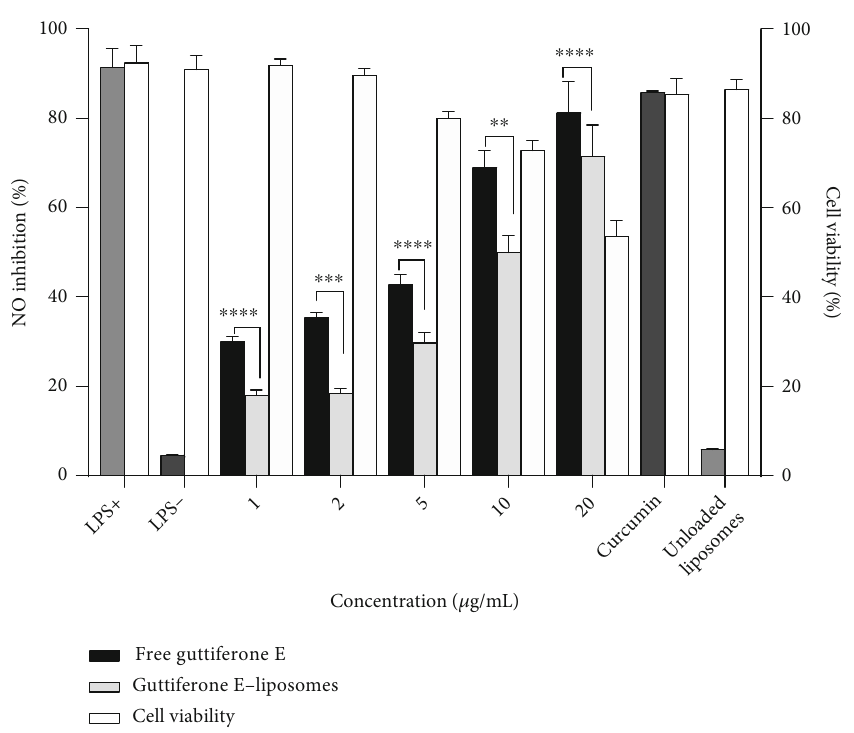
Figure 5: E ff ect of the guttiferone E-loaded liposomes on the nitric oxide production in LPS-stimulated macrophages compared to free GE. MH-S cells were incubated with the indicated concentrations of guttiferone E and guttiferone E-loaded liposomes, for 24h in the presence (+) or absence (-) of LPS; then, from the supernatant, NO was detected and analyzed using the Griess reagent. Curcumin (Cur) at 5 μ g/mL was used as a positive control and unloaded liposomes as a vehicle control at 20 μ g/mL. Data are the mean from three independent experiments. Dunnett ’ s multiple comparisons test using two-way ANOVA was performed: ∗ p < 0 : 01 , ∗∗∗ p < 0 : 001 , and ∗∗∗∗ p < 0 : 0001 for free guttiferone E versus guttiferone E-loaded